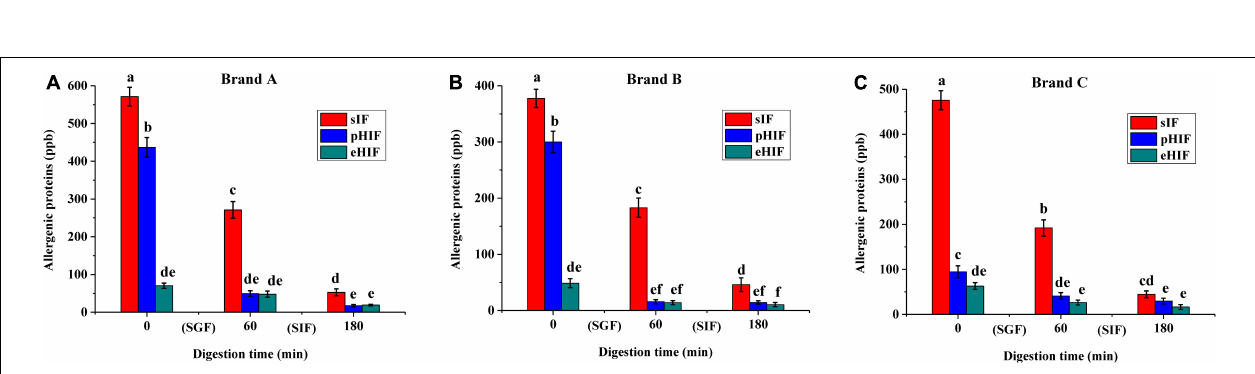
FIGURE 2 | The contents of allergenic proteins in infant formula, n = 3 independent experiments. (A–C) Represent infant formula of brands (a–c) during SGF and SIF digestion stages, respectively.